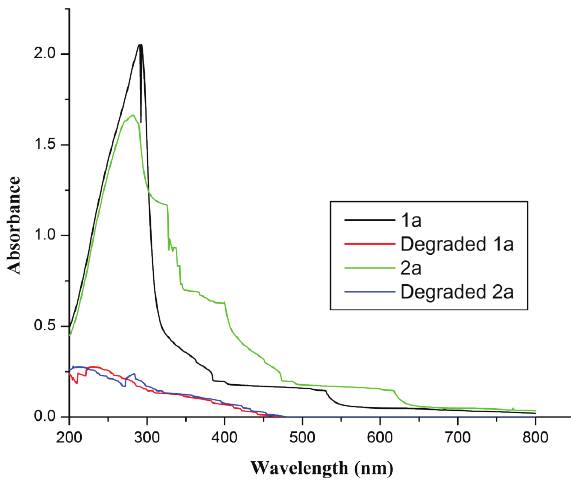
Figure 3: UV-Vis spectra of absorbers in aqueous solution (500 ppm) before and after degradation in Fenton